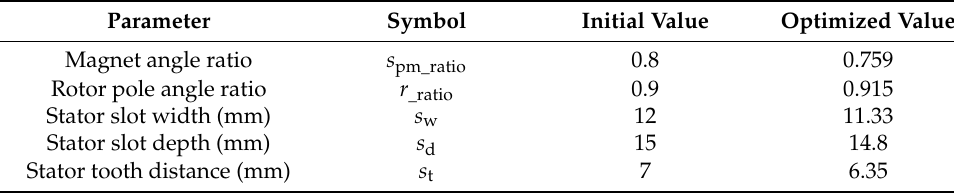
Table 4. Comparations of variable parameters of the proposed machines.